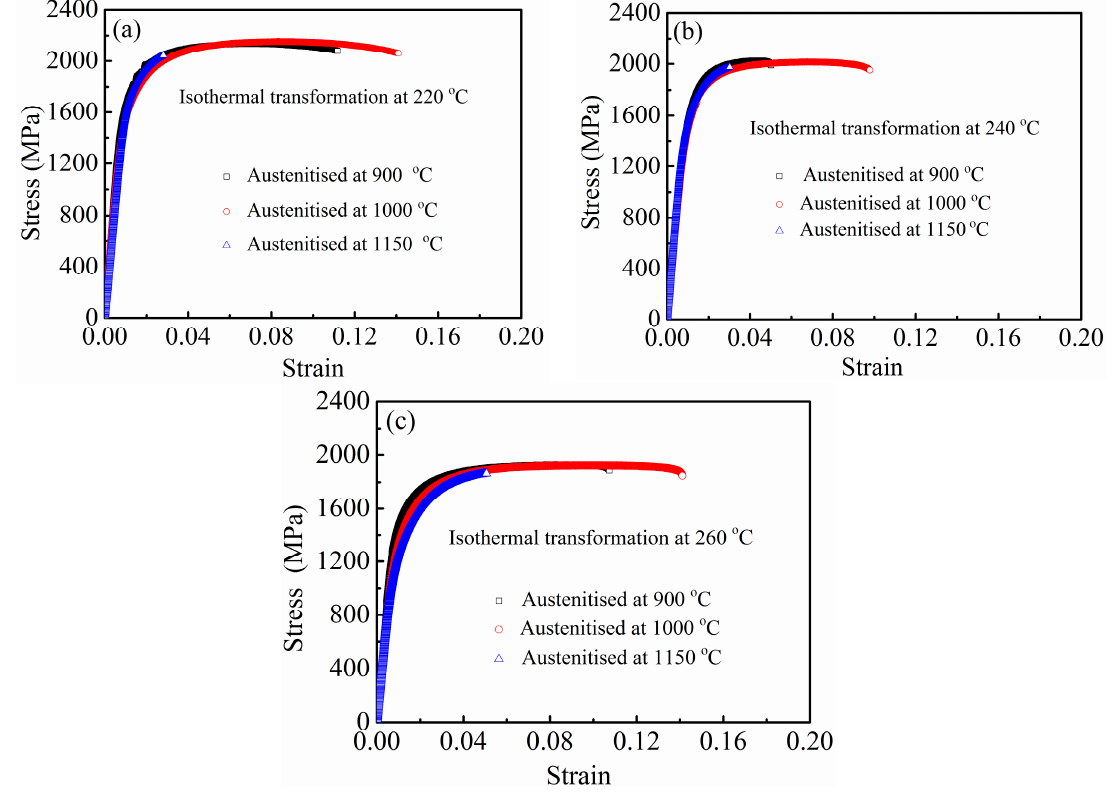
Figure 5. Engineering stress-strain curves of samples isothermally transformed at ( a ) 220 °C; ( b ) 240 °C; and ( c ) 260 °C after austenitisation at different temperatures.